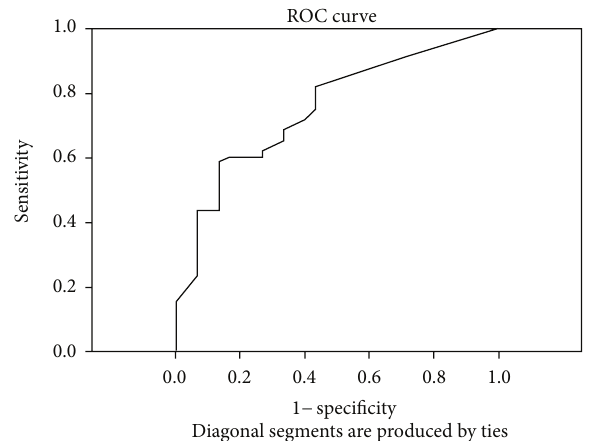
Figure 2: The ROC curve for hs-CRP indicating the optimal cut-off value of 3.75 mg/L (sensitivity 43.3%, specificity